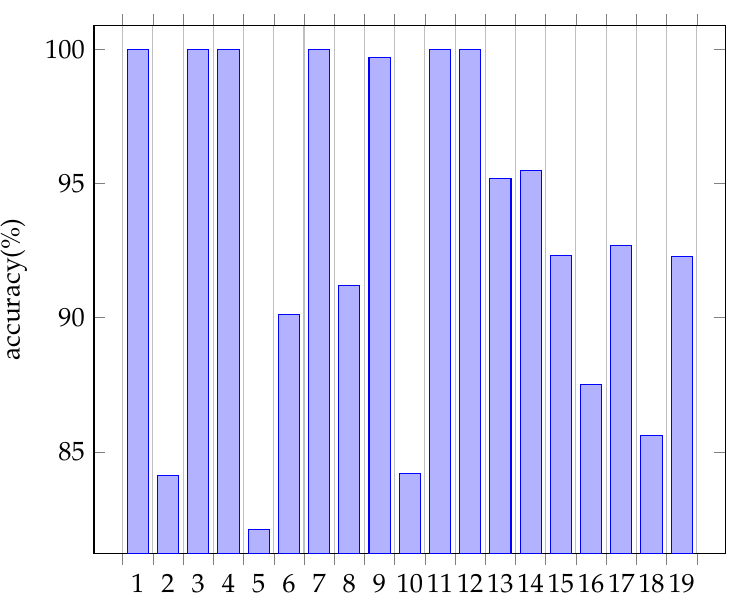
Figure 10. Character recognition rates for screenshot table images.